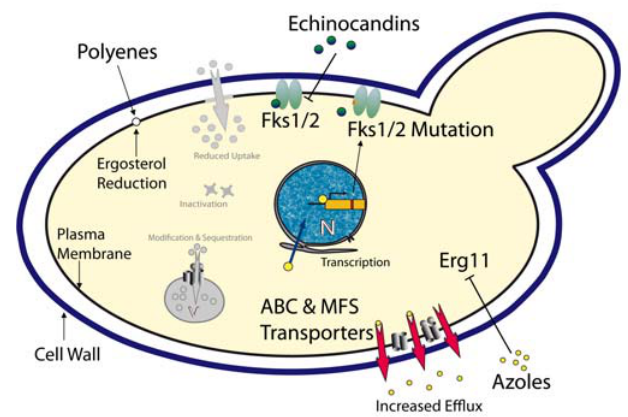
Figure 1. Prevalent antifungal drug resistance mechanisms in Candida glabrata . The cartoon depicts the major principal mechanisms causing antifungal drug resistance in C. glabrata , and indicates the actual drug